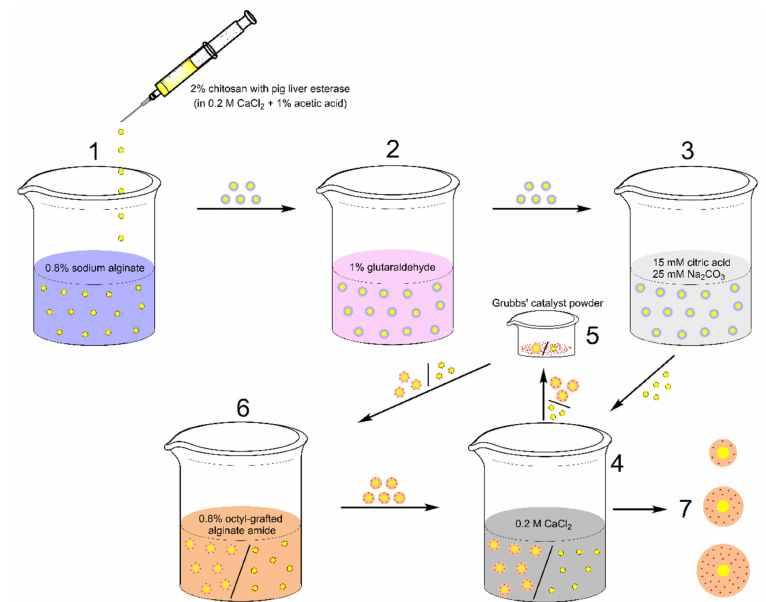
Scheme 2. Schematic procedure for creating multicompartment beads: 1. Creating liquid